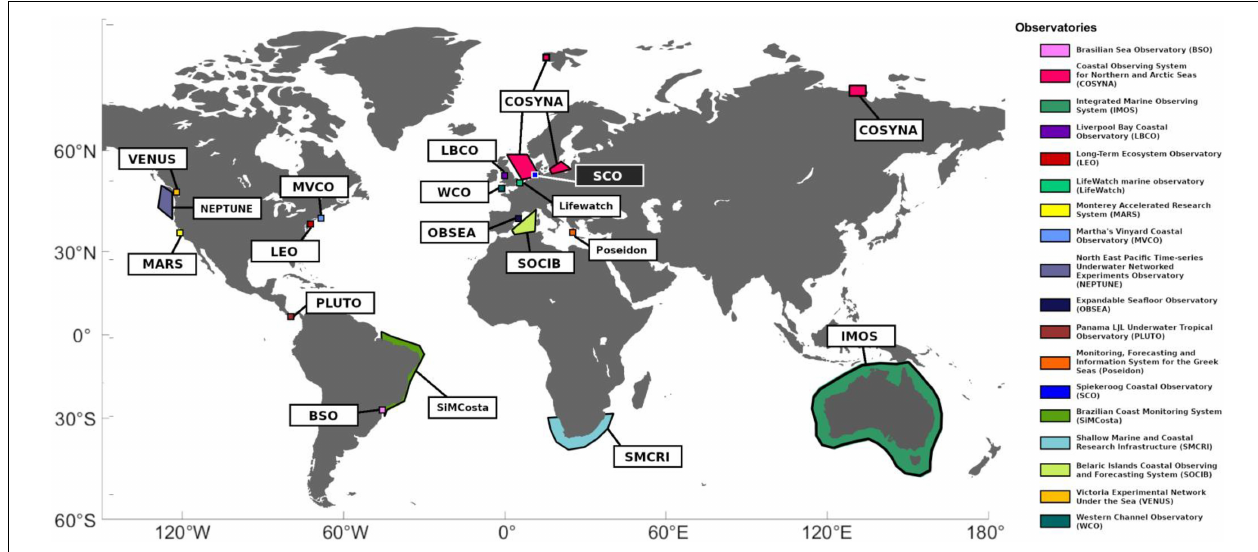
FIGURE 1 | Overview coastal observatories. This map displays a variety of coastal observatories on different spatial and political scales. The observatories are color-coded and their abbreviations are explained within the